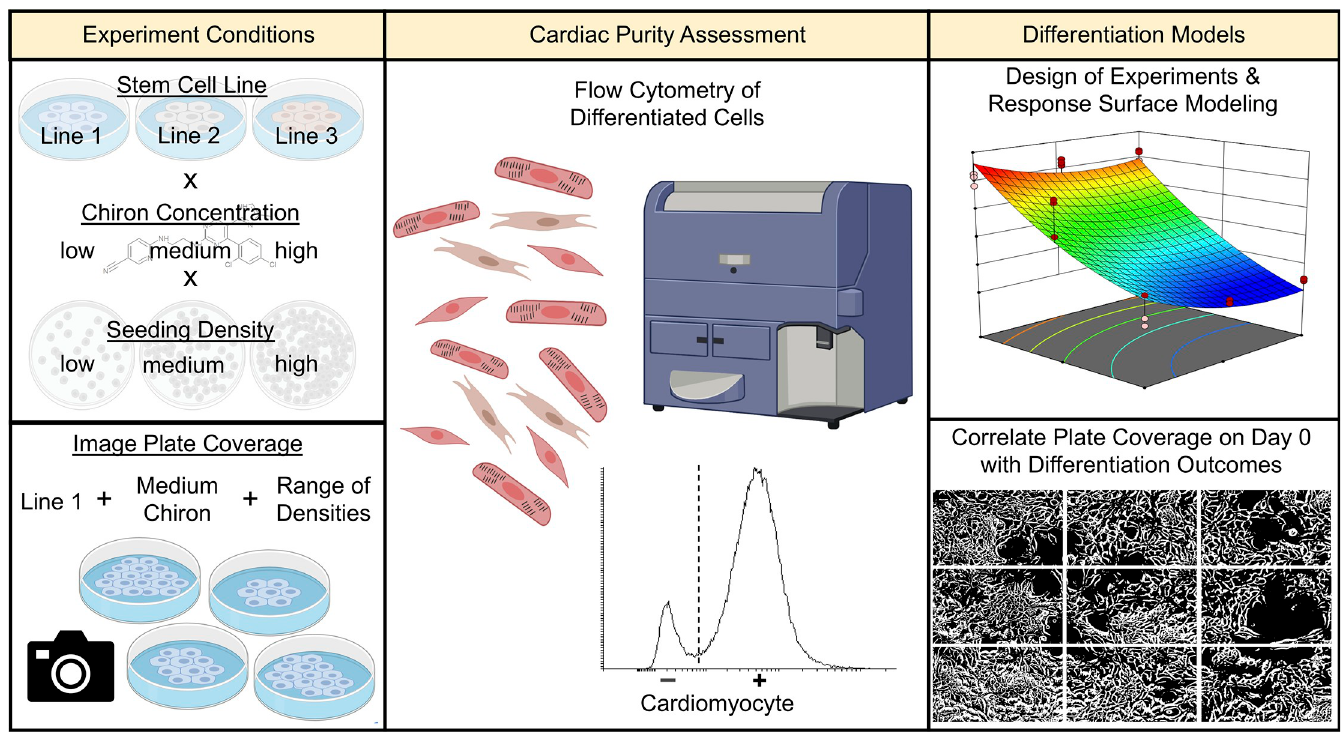
Fig 1. Schematic of differentiation optimization experiments. Left column: Design of experiments (DOE) studies were performed using three hiPSC lines (GiPSC, NCRM-5, WTC11), three Chiron concentrations (3, 6, 9 μ M), and three seeding densities (60, 66, 72 x10 3 cells/cm 2 ; top). Image analysis studies were performed by imaging one hiPSC line (GiPSC) with one Chiron concentration (6 μ M) at the beginning of differentiation across a range of seeding densities (bottom). Middle column: Output cell populations of all studies were analyzed by flow cytometry to identify percentage of cardiomyocytes by expression of cardiac troponin T. Right column: Cardiomyocyte purity was modeled as a function of seeding density and Chiron concentration (top). Phase contrast images of cells at the beginning of differentiation were correlated with cardiomyocyte purity through automated image analysis in Matlab (bottom).